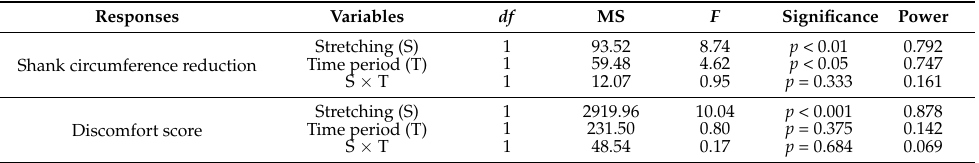
Table 1. Two-way analysis of variance